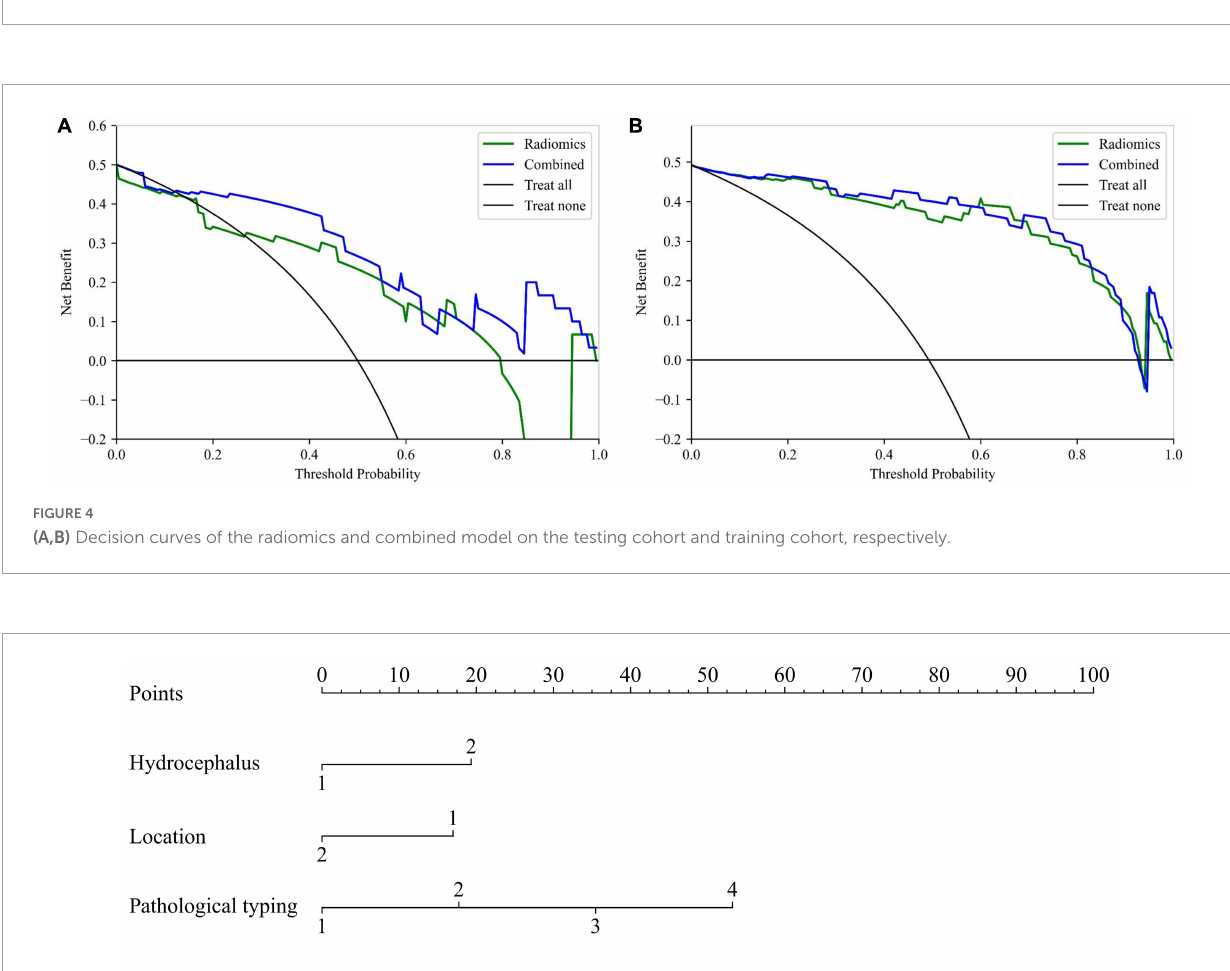
FIGURE3 (A,B) Calibration curves of the radiomics and combined model on the testing cohort and training cohort, respectively.